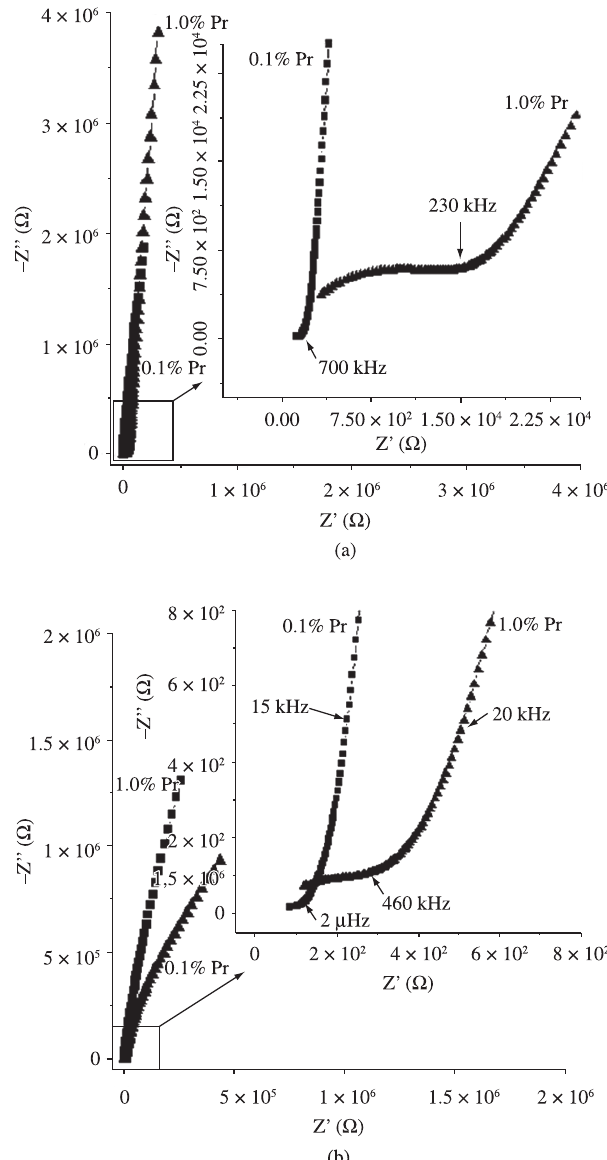
Figure 4. Nyquist diagram for ZPC system with 0.1 and 1.0 mol% of Pr sintered at a) 1300 °C and b) 1350